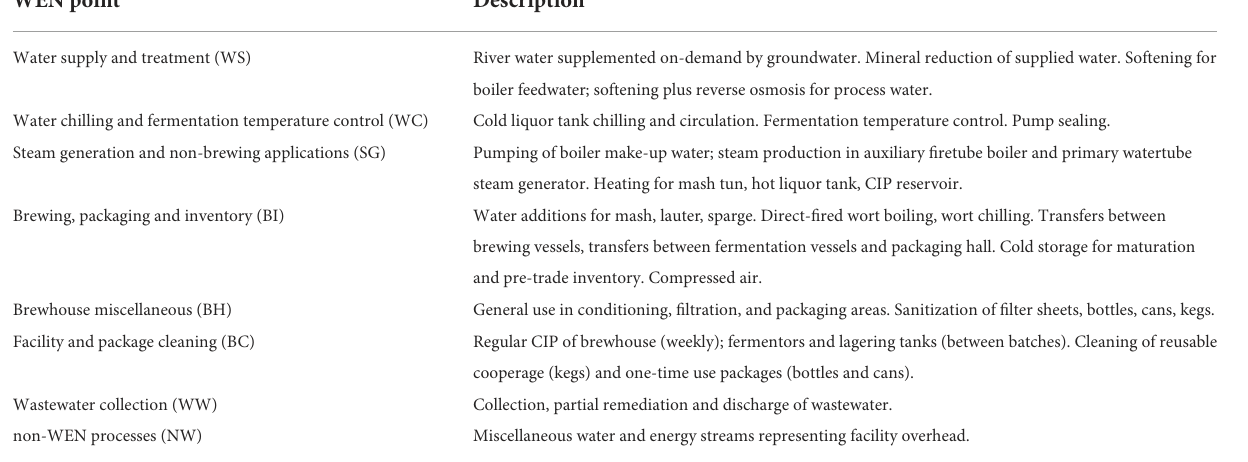
TABLE 1 Water energy nexus (WEN) points within the